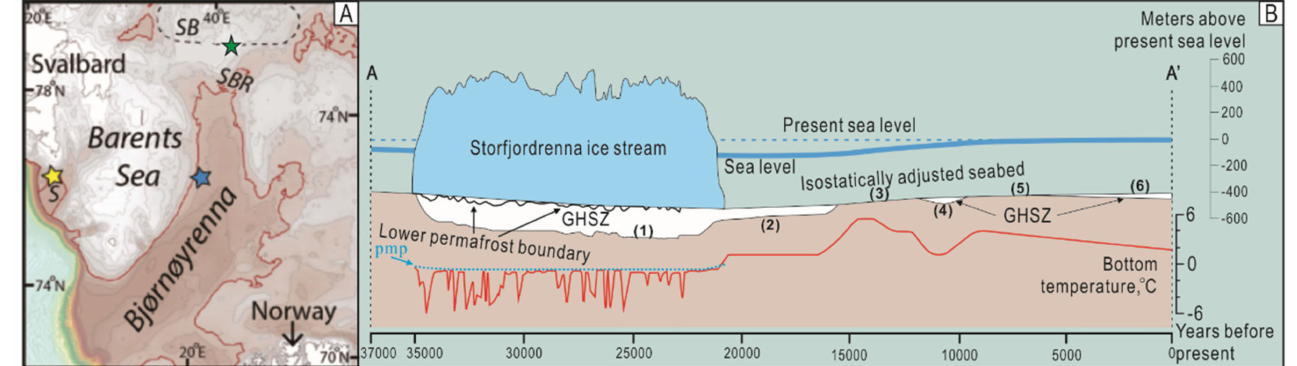
Figure 6. ( A ) Places where mounds and/or craters have been observed in the Barents Sea. Note: Blue star: Bjørnøyrenna; yellow star: Storfjordrenna; green star: Storbanken (modified from [42]). ( B ) Over the past 37,000 y, GHP sites have witnessed changes in the thickness of ice and GHSZ, bottom temperature, sea level, and isostatically adjusted seabed. Thereunto, (1) a subglacial GHSZ with 200 m thickness lasted 13,500 y at GHP sites. (2) After final deglaciation, an inherited glacioisostatic depression allowed a 100 m thick GHSZ to persist at GHP sites until 15,000 y ago. (3) Inflowing warm Atlantic water at 4–5 ◦ C related to Heinrich event 1 and destabilized remnants of the GHSZ. Large-scale hydrate-bound gas is released through gas chimneys toward the seafloor to initiate the growth of the GHPs. (4) The Younger Dryas cold event induced extensive GHSZ regrowth. (5) Rapid recession of the GHSZ occurred, linked with a warm bottom water period at the Holocene Optimum. (6) Since 6500 y ago, modern oceanographic conditions have favored moderate hydrate growth at GHP sites (summarized from [40], and references